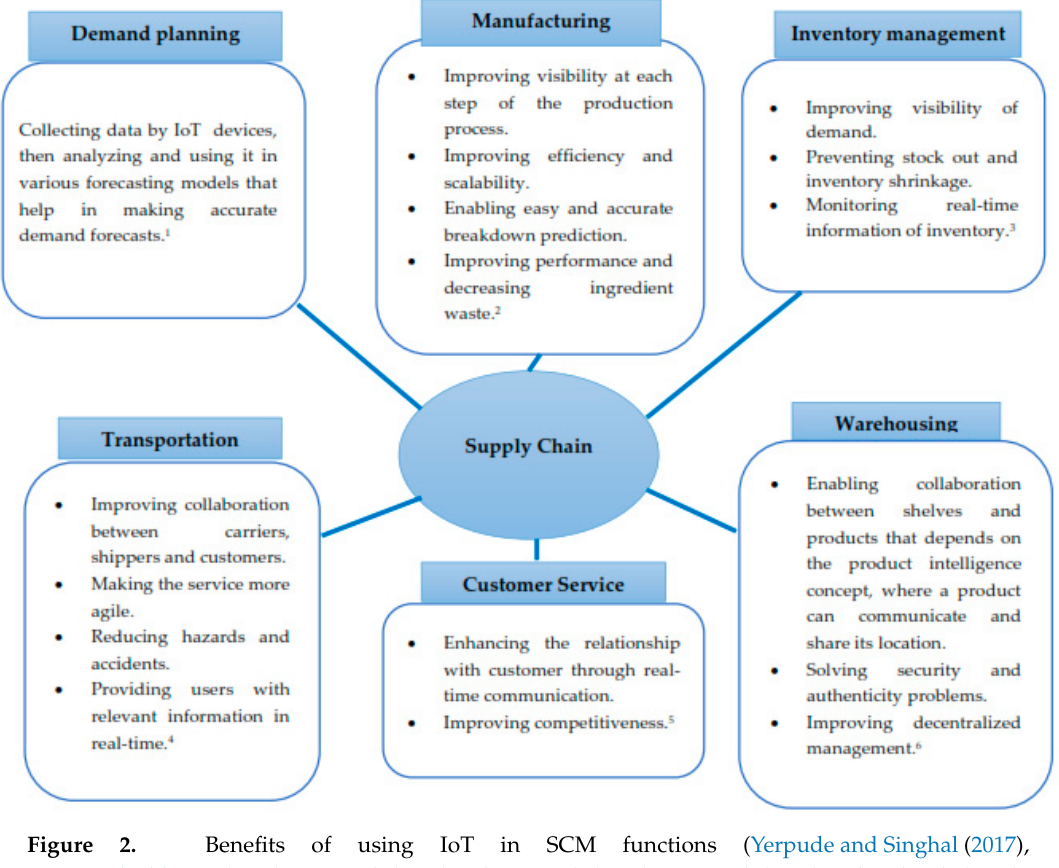
Figure 2. Benefits of using IoT in SCM functions (Yerpude and Singhal (2017), Anita and Abhinav (2017), Qin et al. (2017), Schoen et al. (2016), Ives et al. (2016) and Richards (2017).